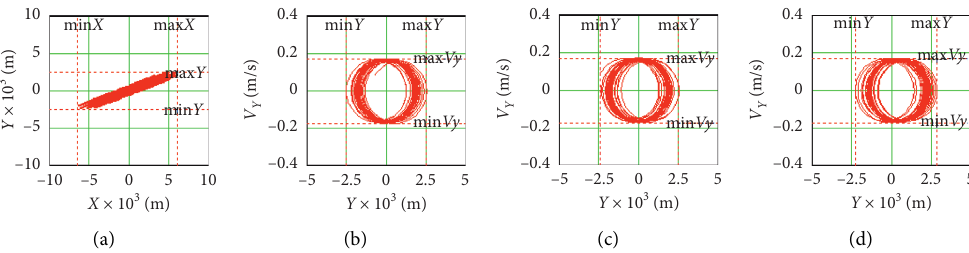
Figure 8: Motion orbit (a) and PSP of vibrating screen: (b) with new springs; (c) with less by 20% stiffness K (nonlinear K Y